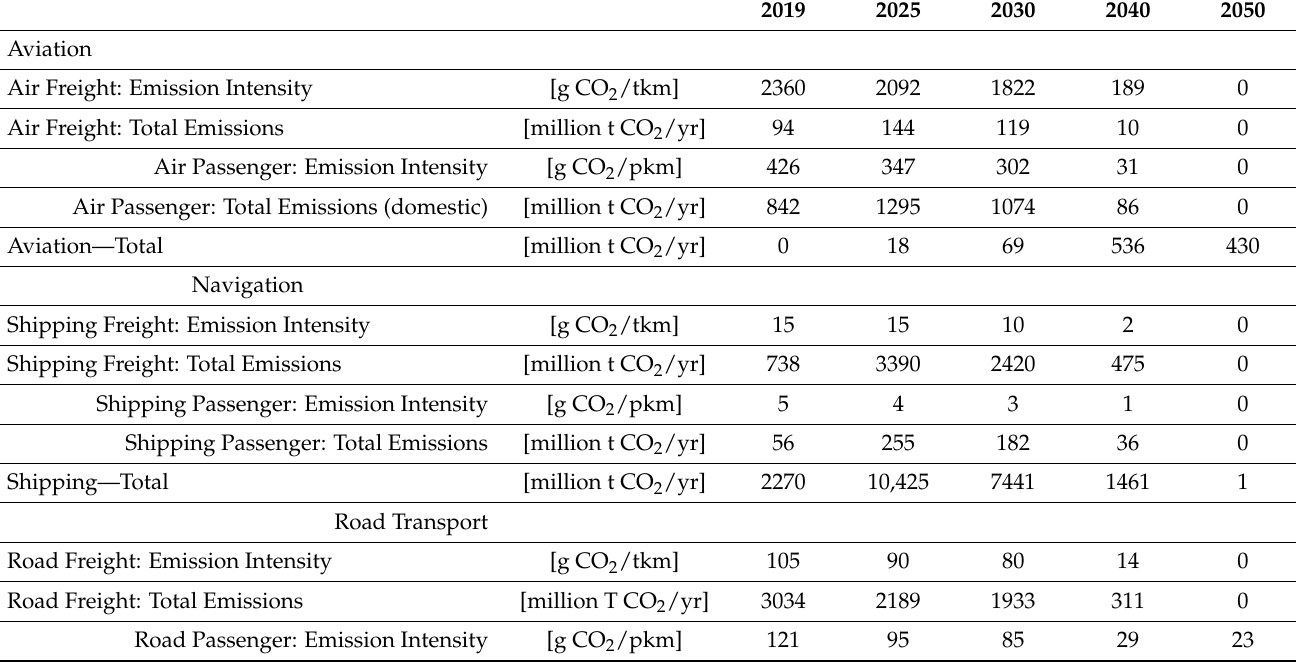
Table 22. Transport: carbon intensity and total energy-related CO 2 emission by sector for the